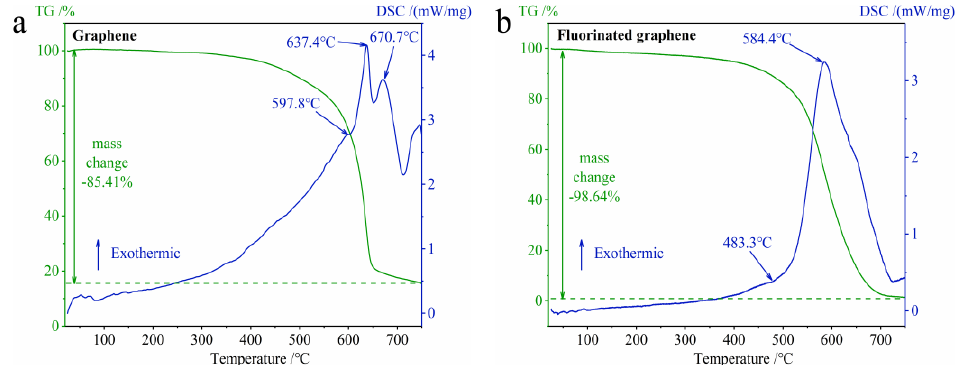
Figure 9. TG-DSC curves of graphene and fluorinated graphene under O 2 at 25–750 ◦ C. ( a ) TG-DSC curves of graphene. ( b ) TG-DSC curves of fluorinated graphene.